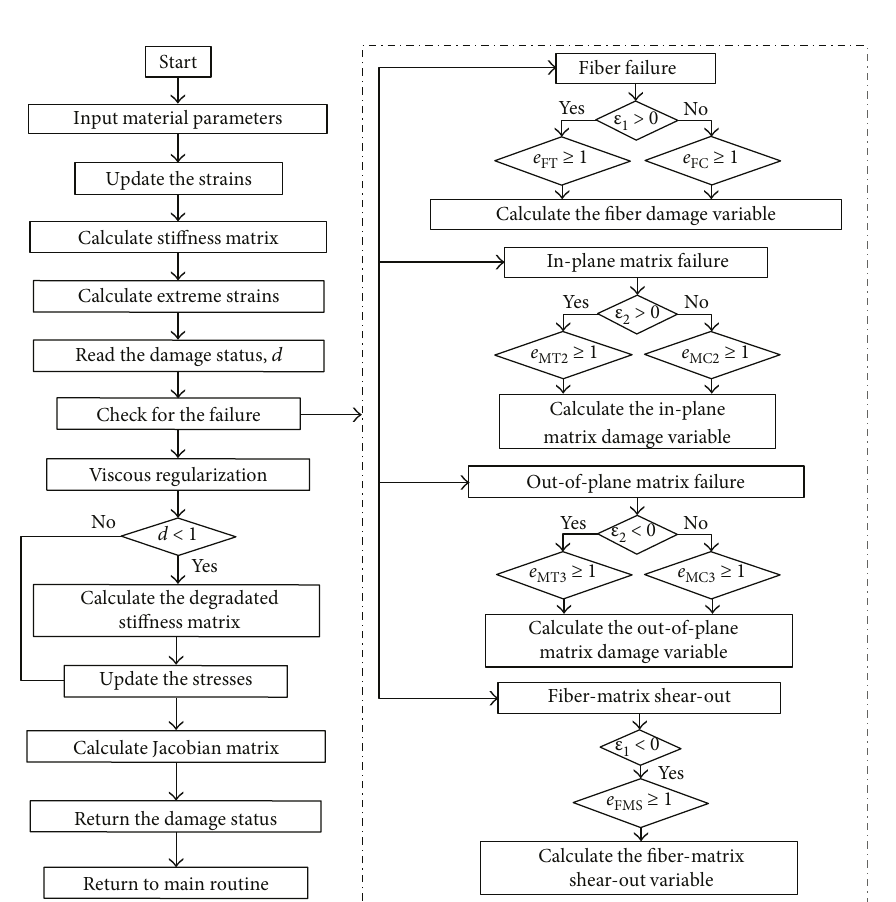
Figure 3: Flowchart of the UMAT subroutine.